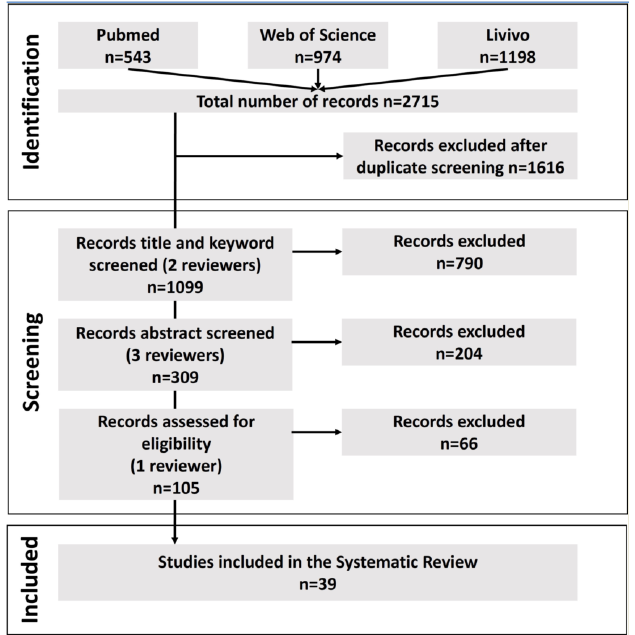
Figure 1. Record extraction and review process for the literature search during the systematic literature review to find impacts of procedures and human-animal interactions during transport and slaughter on animal welfare of pigs in accordance with the PRISMA (Preferred Reporting Items for Systematic Reviews and Meta-Analyses) guidelines [12] .